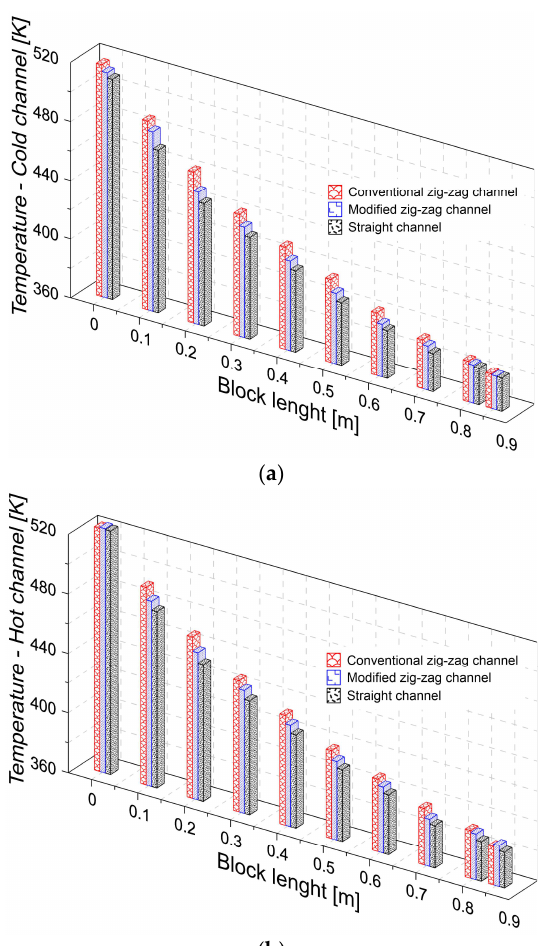
Figure 11. Flow temperature values of PCHE blocks: ( a ) hot channel; ( b ) cold channel.